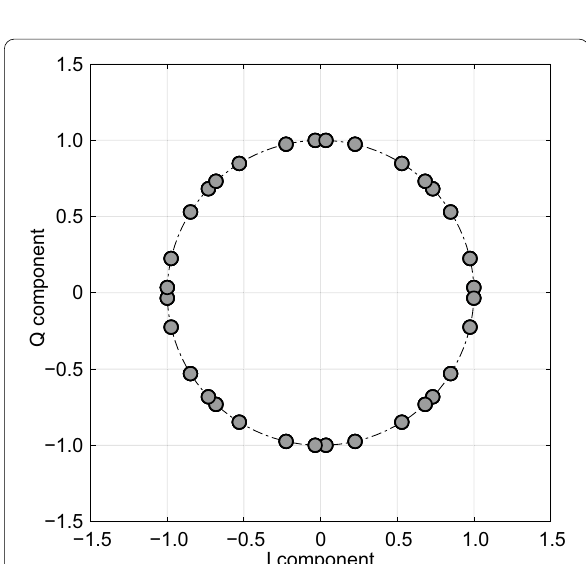
Fig. 1 Multiplexing modulation constellation of Type-II ACE-BOC